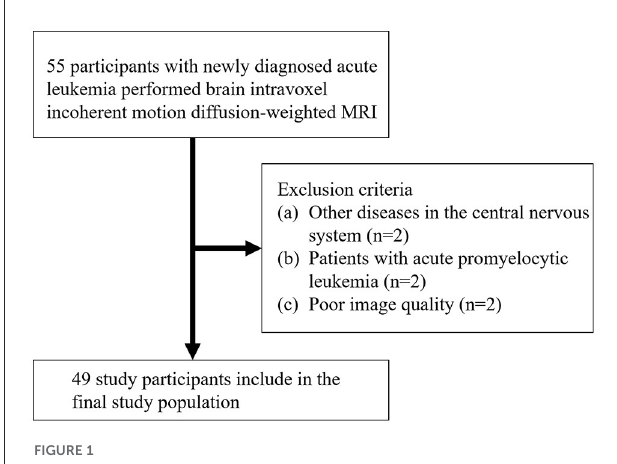
FIGURE1 Participant inclusion and exclusion